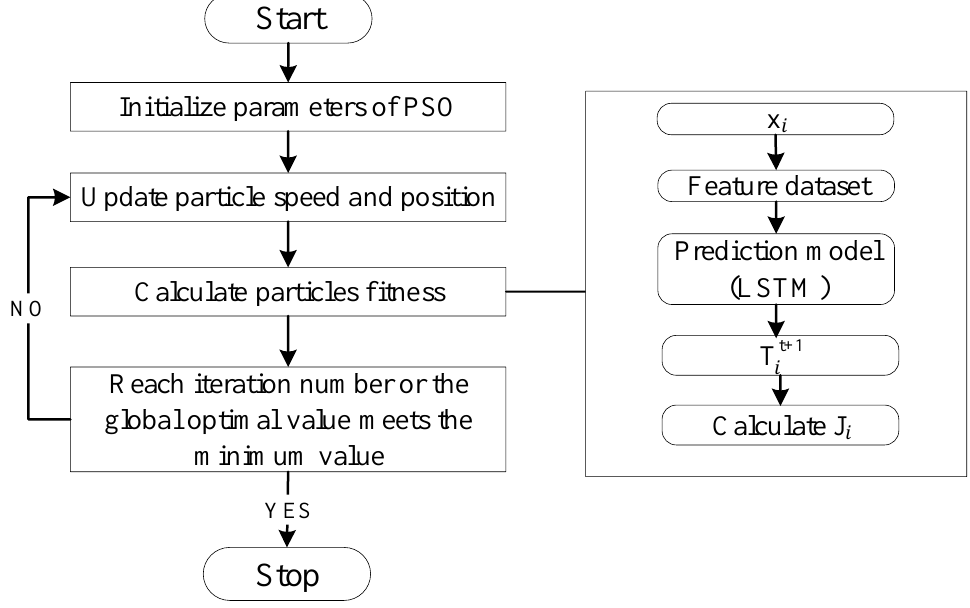
Figure 4. Flow chart of PSO algorithm.